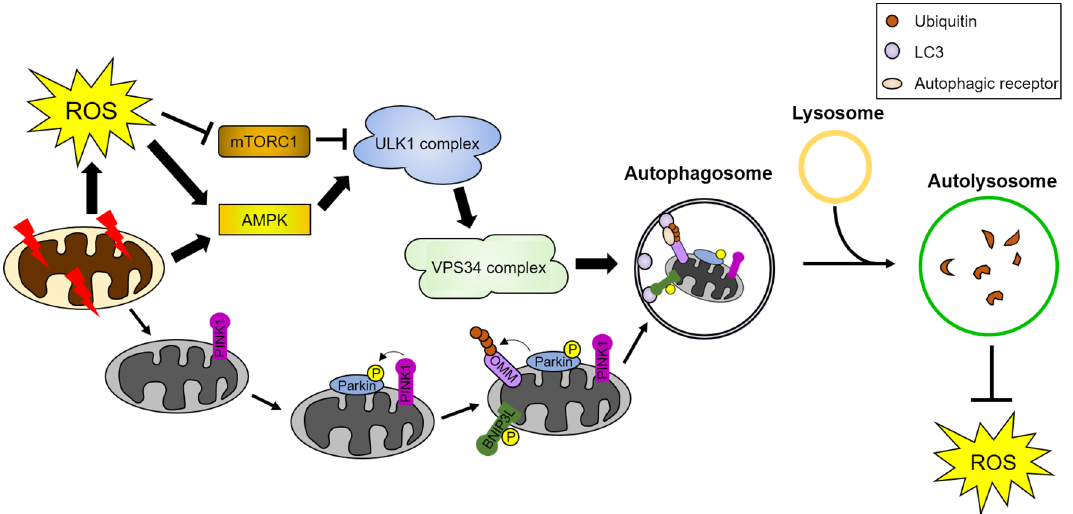
Figure 2. ROS induce autophagy and mitophagy. Damaged mitochondria and cellular stresses generate ROS. ROS activate AMPK and inhibit mTORC1, leading to sequential activation of the autophagy initiation complex, the ULK1 and VPS34 complex. The activated autophagy initiation complex induces autophagosome formation. Autophagosomes engulf cargoes, such as damaged organelles and proteins, and fuse with lysosomes. Autolysosomes degrade the autophagic cargoes. Damaged mitochondria are targeted for degradation by a form of selective autophagy, called mitophagy. PINK1 is recruited to damaged mitochondria and phosphorylates parkin, an E3 ubiquitin ligase, and mitophagy receptors such as BNIP3L/NIX. Parkin-mediated poly-ubiquitination of OMM proteins leads to the recognition of damaged mitochondria by autophagic receptors. These autophagic receptors interact with the ATG8 family proteins and transport the damaged mitochondria to autophagosomes for their degradation. Detailed pathway is described in Section 4. AMPK: AMP-activated protein kinase, BNIP3L: Bcl2 interacting protein 3 like, mTORC1: mammalian target of rapamycin complex 1, OMM: outer mitochondria membrane proteins, and PINK1: PTEN-induced kinase